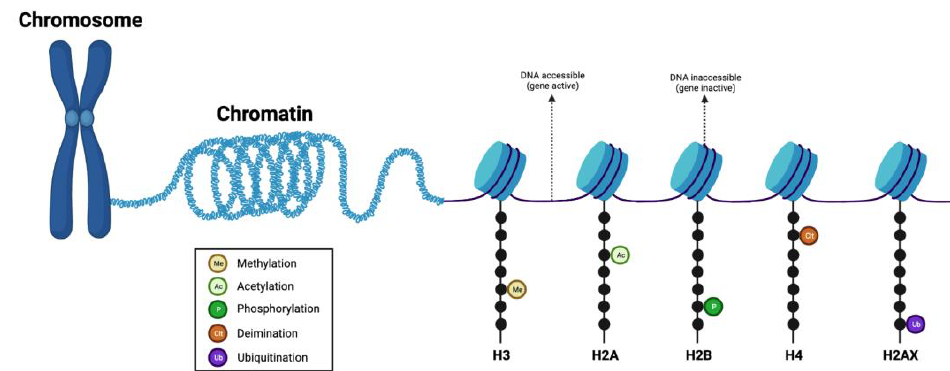
Figure 2. Graphical representation of the histone complex and modifications. Histone modifications determine the extent of chromatin wrapping around the histone proteins. Protruding histone tails from the nucleosome can be modified by various post-translational modifications (such as methylation, acetylation, phosphorylation, ubiquitination, and deamination) at different residues. Loosely-coiled chromatin contains transcriptionally accessible DNA regions, while tightly-coiled chromatin contains transcriptionally inaccessible DNA regions. Figure created with BioRender.com (accessed on 26 January 2023).